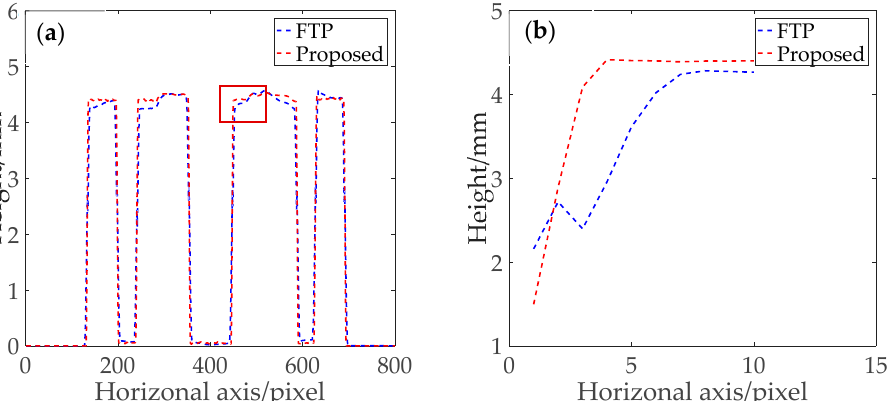
Figure 11. The 540th column data of the reconstructed object: ( a ) the sectional view of the 3D profile of the object; ( b ) the magnified view of the hollow boundary area of ( a ).